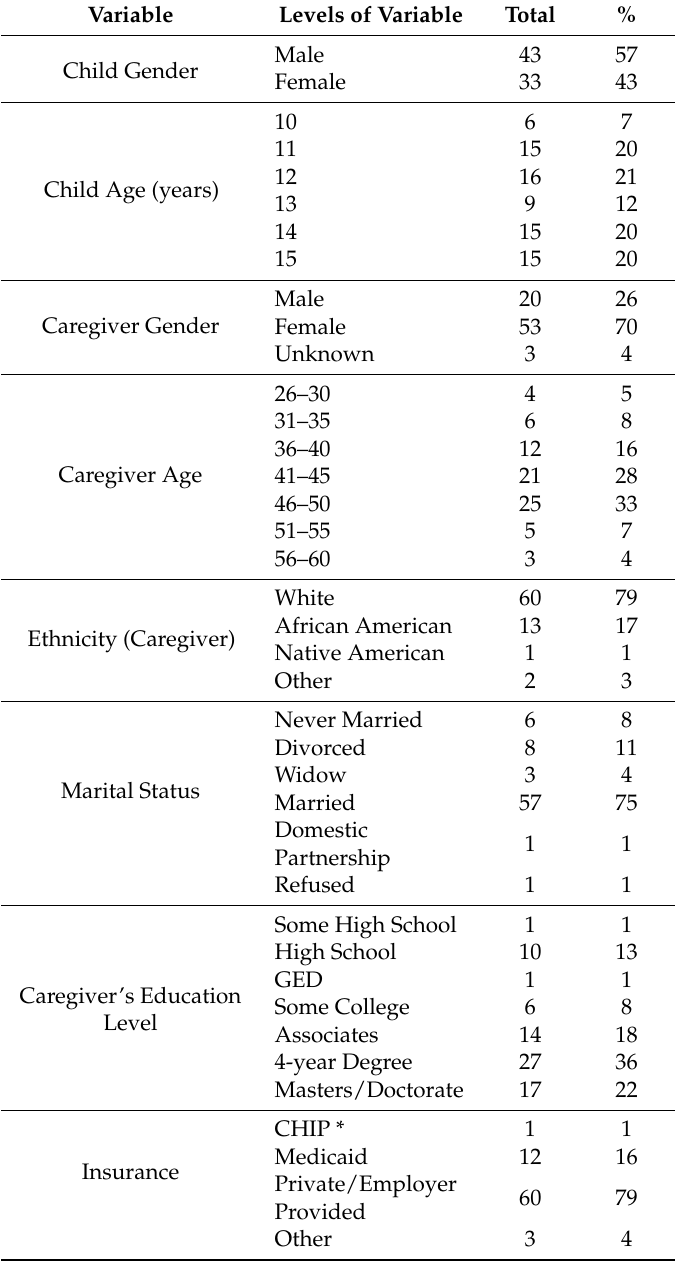
Table 1. Child and caregiver demographic ( n = 75